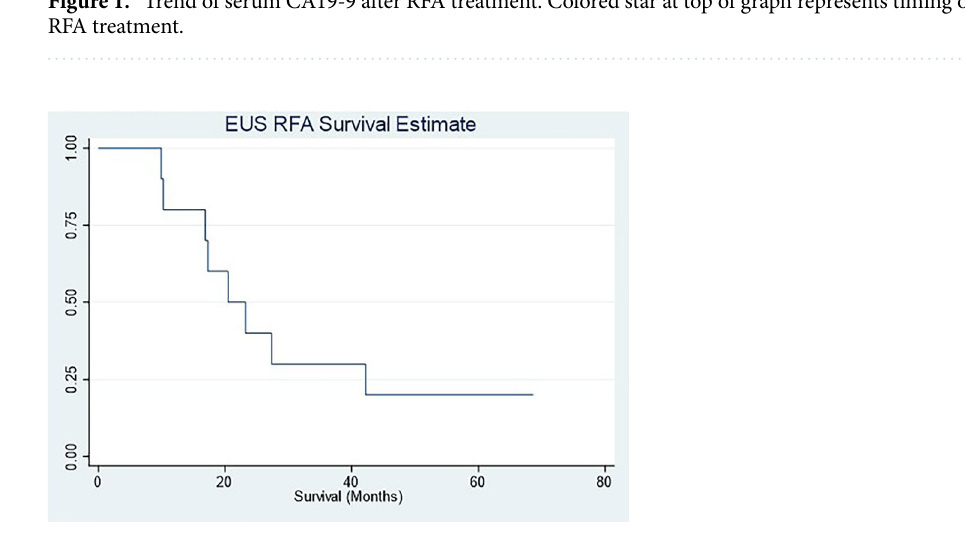
Figure 2. Kaplan–Meier plot to estimate overall survival for patient